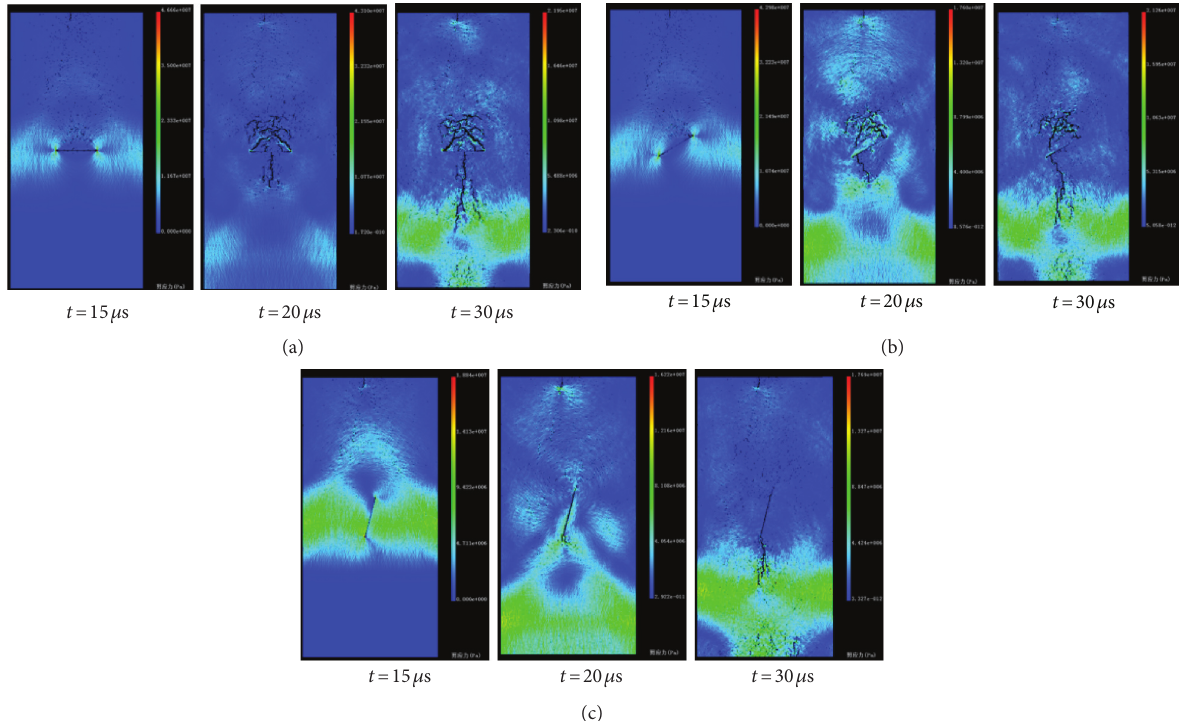
Figure 7: Failure process of rock specimen with different angle preexisting crack. (a) Failure process of flawed rock specimen with α � 0 ° when subjected to stress wave II. (b) Failure process of flawed rock specimen with α � 30 ° when subjected to stress wave II. (c) Failure process of flawed rock specimen with α � 75 ° when subjected to stress wave